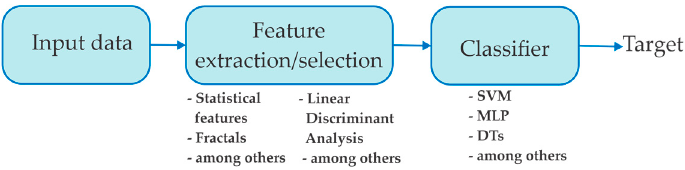
Figure 1. Machine learning framework for designing data ‐ driven classifier schemes.